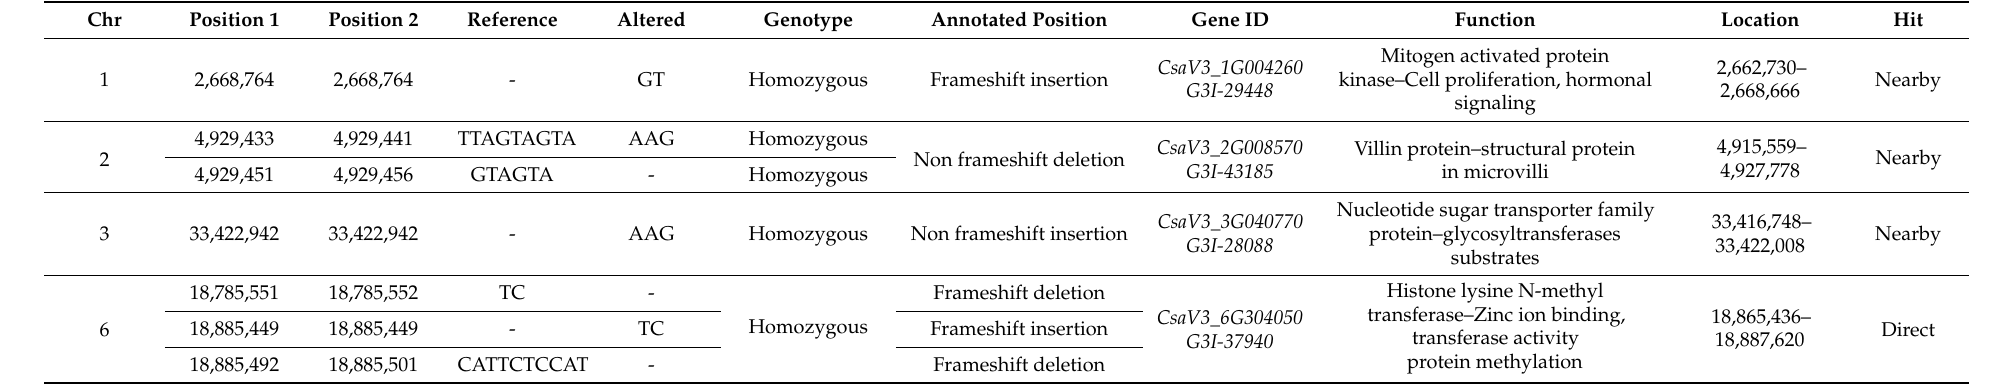
Table 8. List of the male-specific InDels identified on the genes involved in